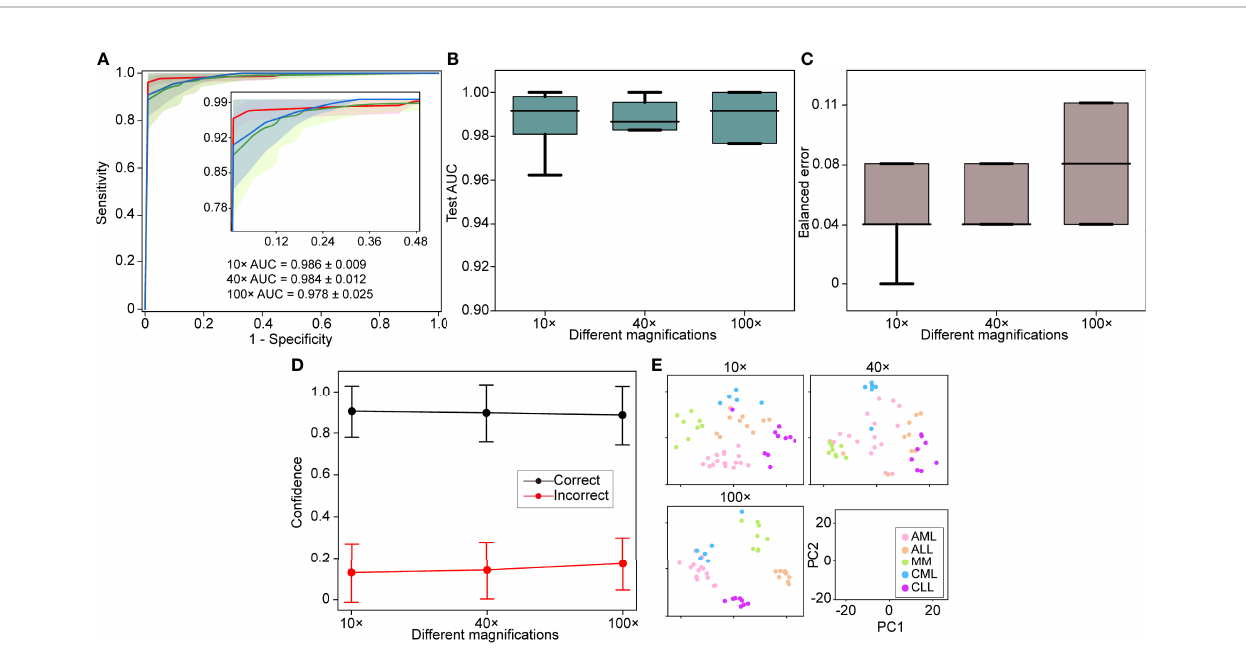
FIGURE 2 | Different magni fi cation performance and comparative analysis. (A) 5-fold mean test macro-averaged AUC ± s.d. of our model using 10×, 40×, and 100× objectives. The con fi dence band shows ±1 s.d. for the ROC. (B) Cross-validation test AUCs. (C) Cross-validation test balanced error. (D) Average con fi dence (± 1 s.d.) of correctly and incorrectly classi fi ed WSIs of the model. (E) Slide-level feature space for a single cross-validated fold using PCA in the validation and test sets. PC, principal